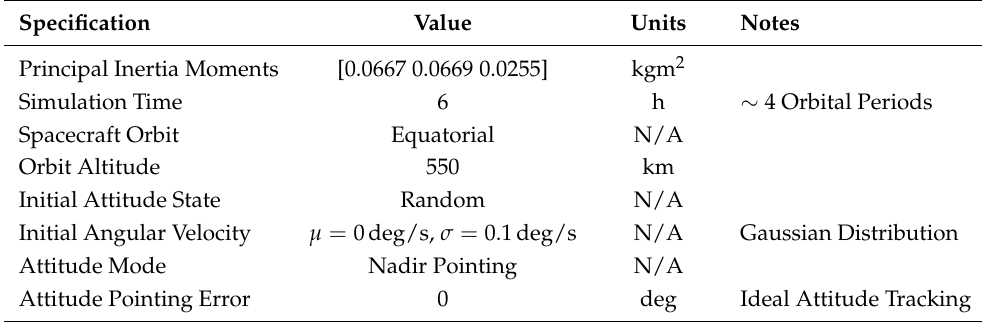
Table 9. Model-in-the-loop simulation